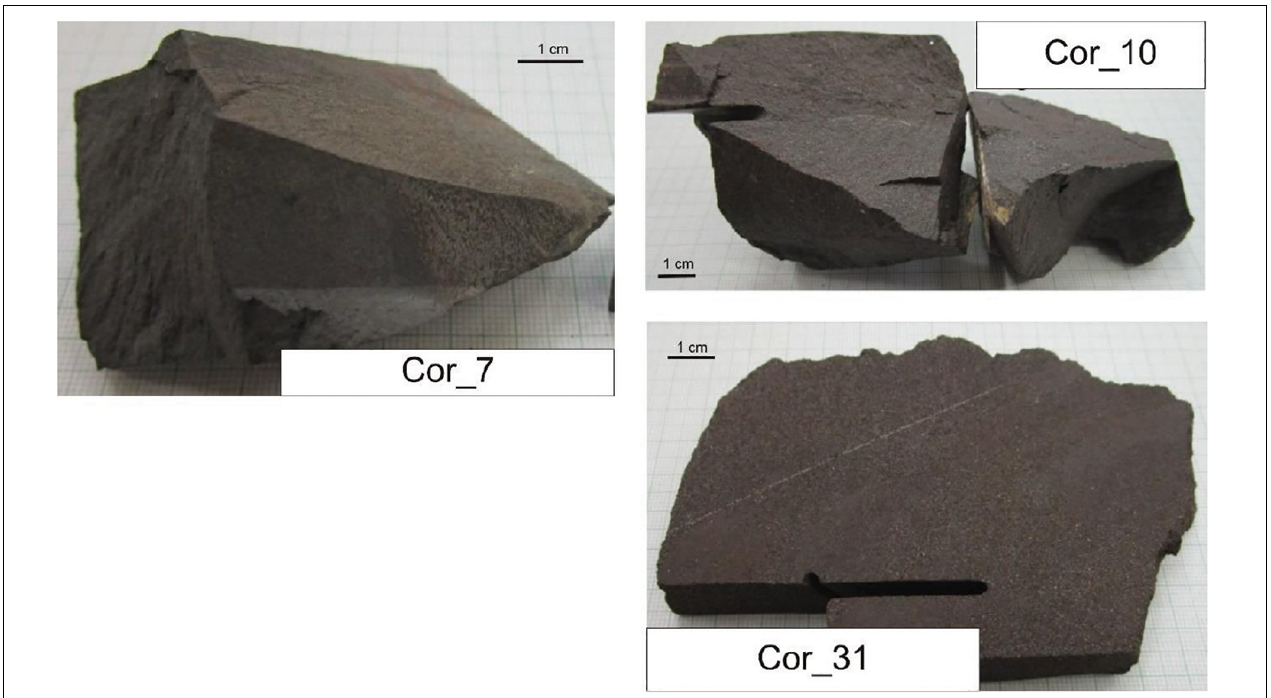
FIGURE 2 | Representative samples from Mn-1 ore bed of Urucum Mn deposit. Samples COR-7 and -10 were collected at Figueirinha Mine, Santa Cruz N plateau, and sample COR-31 was collected at Saõ Domingos Mine, Santa Cruz SW plateau.